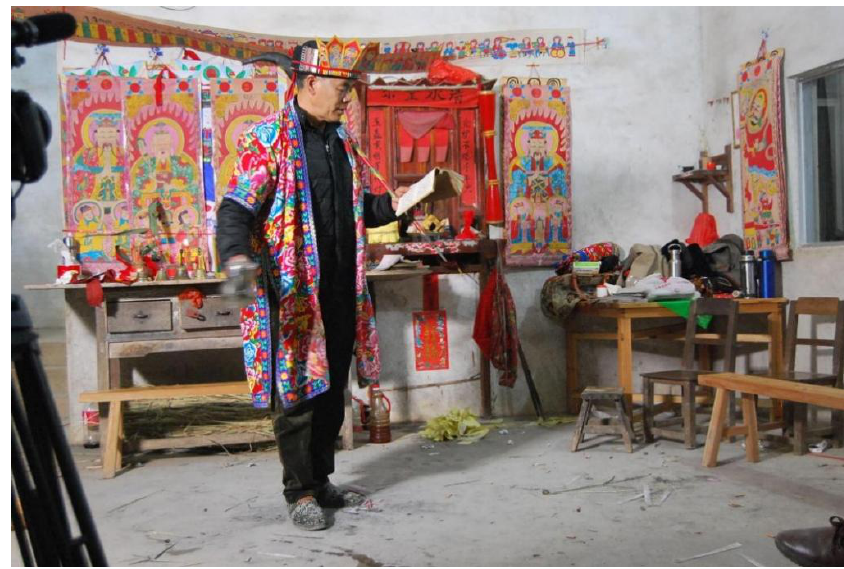
Figure 9. Zhao Weufu chanting the spell to invite the gods .